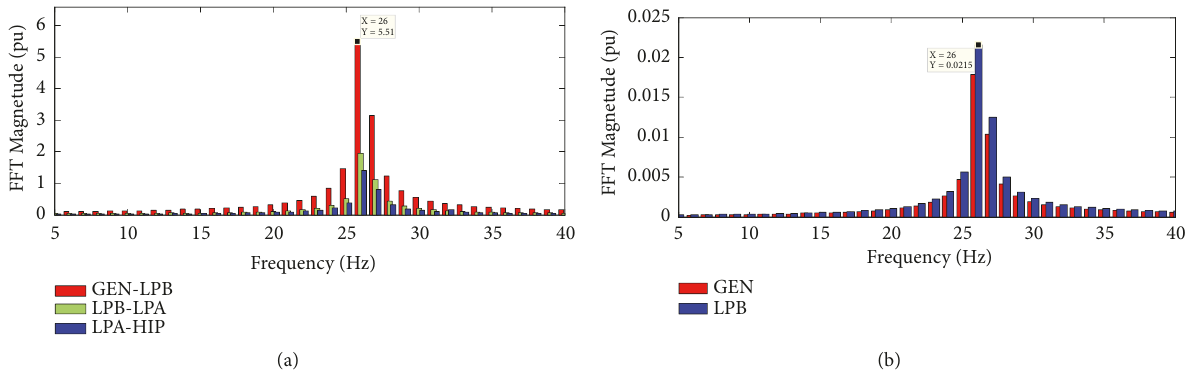
Figure 7: FFT analysis of shaft torque for the validation of resonant frequency: (a) GEN-LPB, LPB-LPA, and LPA-HIP shaft sections; (b) GEN and LPB shaft sections.